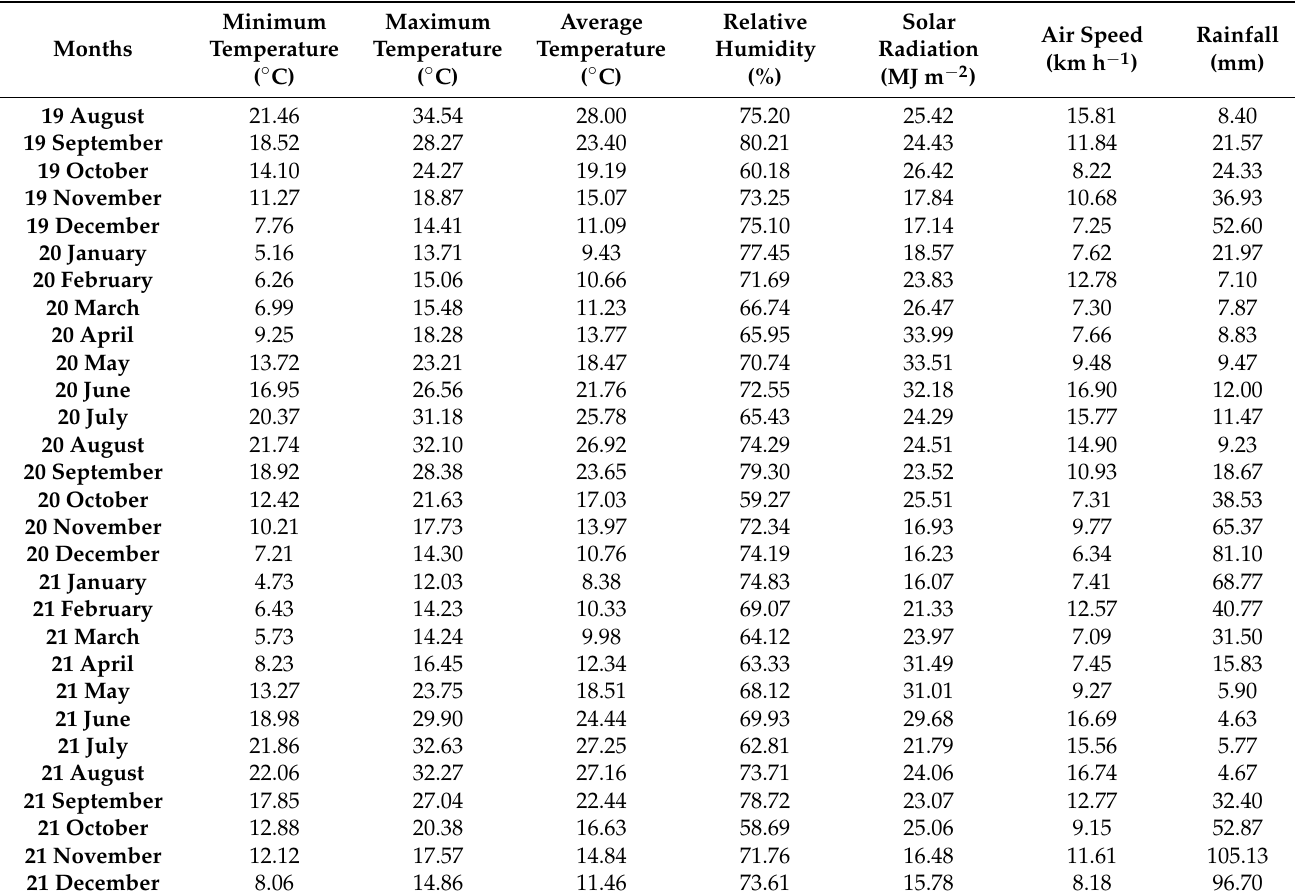
Figure A2. Box plot correlations of environmental parameters at Apulia region over the study pe- riod from 1 January 2019 to 31 December 2021. (Note: Tmin, Tmax and Tave = minimum, maximum, and average temperatures (°C); relative humidity at 9:00 to 21:00 (local time) (%); solar radiation (MJ m 2 month −1 ); wind speed (m s −1 ); and rainfall (mm)). References 1.